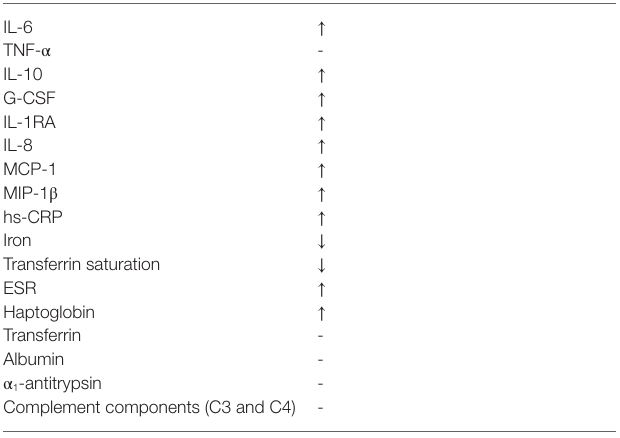
TABLE 4 | Inflammation markers after an ultramarathon.